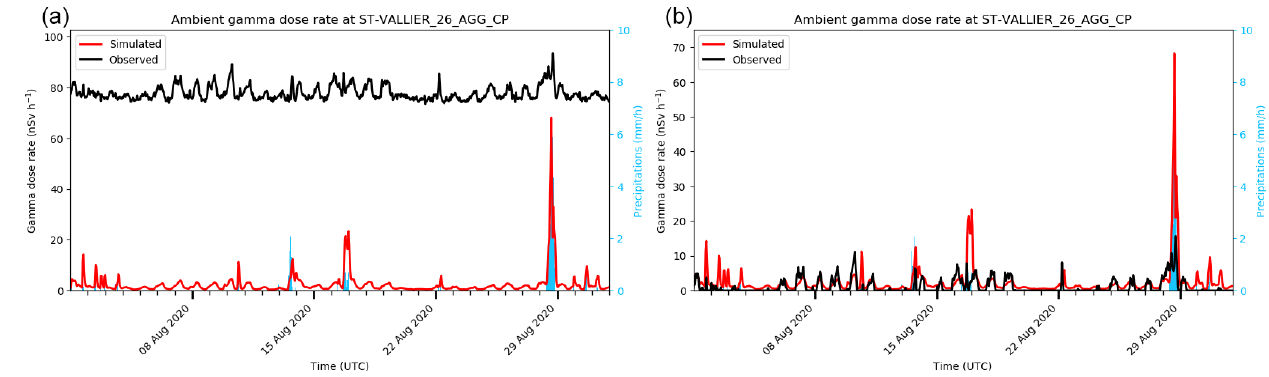
Figure 5. Example of background radiation subtraction. In black, the observed gamma dose rate. (a) Raw data. (b) Data after background radiation subtraction. (In red, simulated values.)